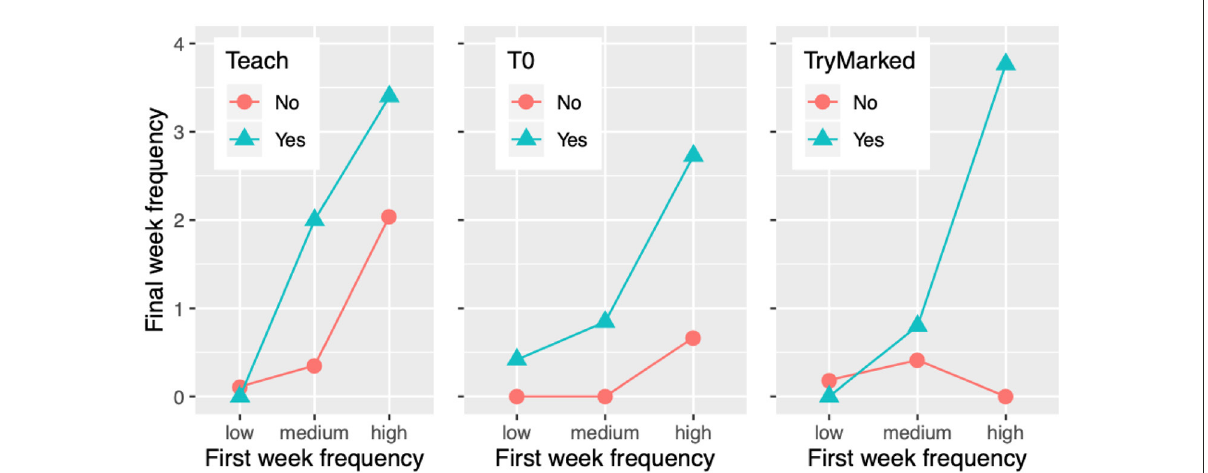
FIGURE7 Relationships between frequency and interactional effects for teaching (left) , T0 (middle) and Try-marking (right) . The vertical axis shows the frequency in the final week. The horizontal axis shows the frequency in the first week, cut into three bins by tertile (1–2, 3–6, 7 + ). Points on the graph show mean frequency for a given interactional type and first week frequency bin. Since the purpose is to illustrate the direction of interaction effects, the uncertainty is not